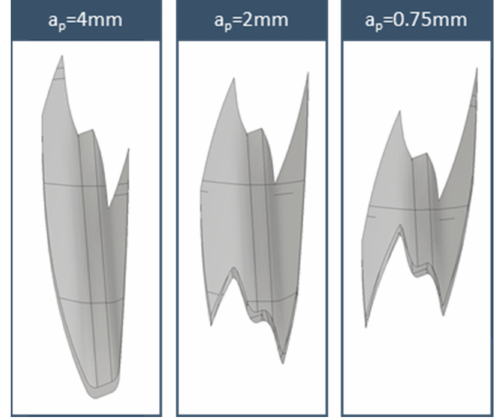
Figure 13. Solid chip geometries for strategy 3.